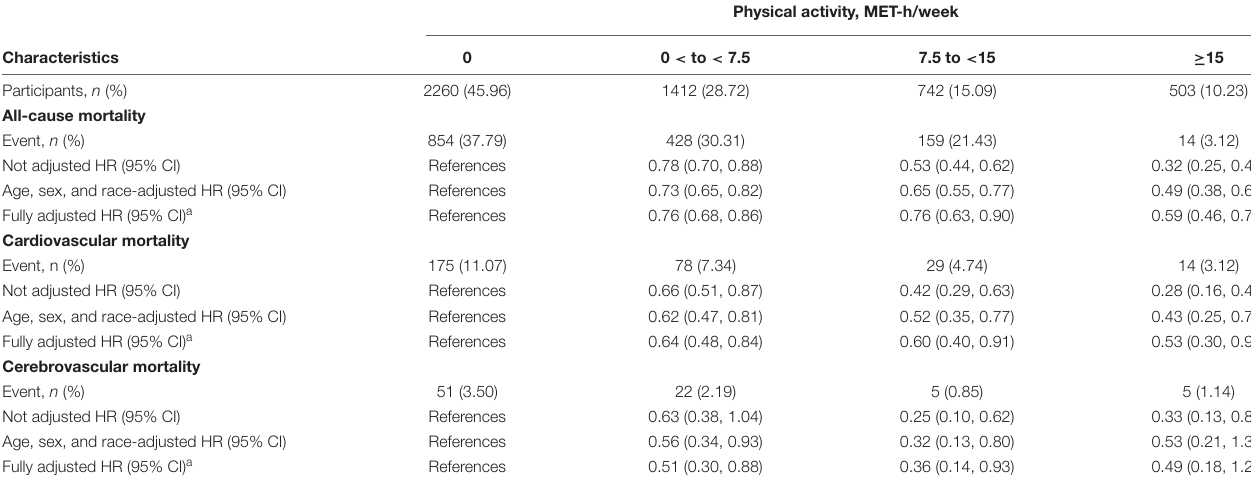
TABLE 3 | PA and risks for all-cause and cardiocerebrovascular mortality in four quantiles.